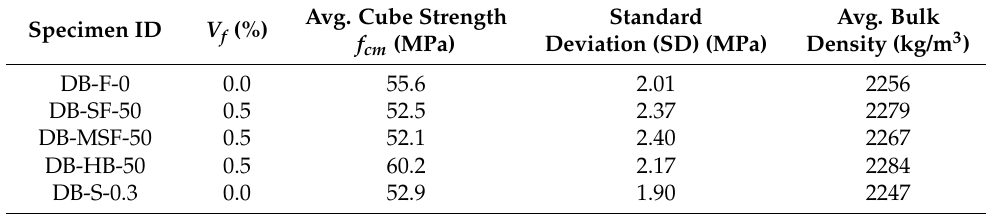
Figure 3. Deep beam specimen details. Table 1. Compressive strength properties of